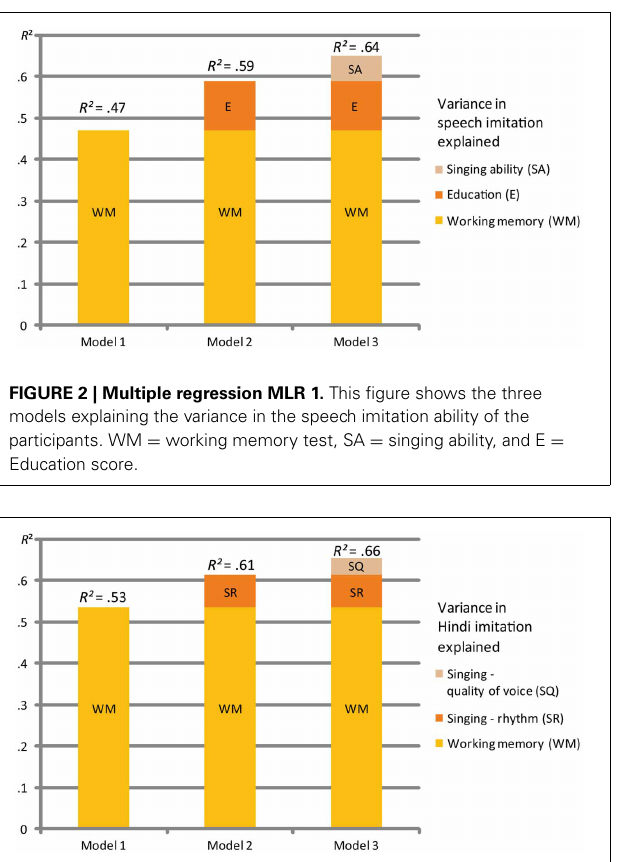
FIGURE 3 | Multiple regression MLR 2. This figure shows the three models explaining the variance of the Hindi imitation task of the participants. WM = working memory test, SR = singing criteria: rhythm, SQ = quality of